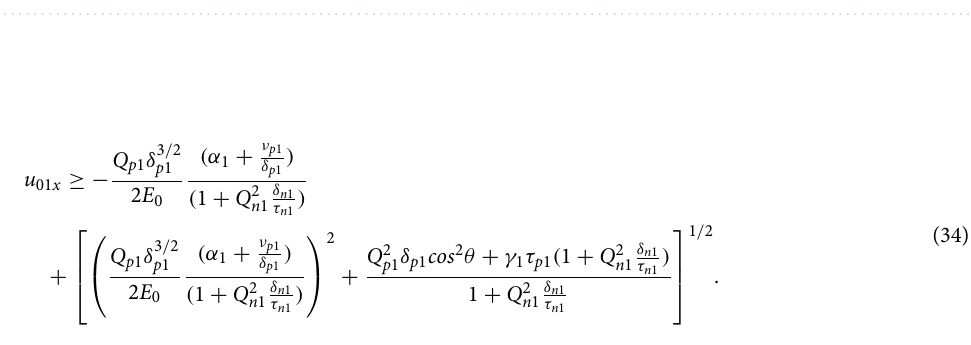
Figure 3. Variation of the normalized density distribution of the charged particles toward the wall for ν p 1 = 0, u 01 x = 0.622, τ p 1 = 0 (dotted-dashed line), ν p 1 = 0, u 01 x = 0.804, τ p 1 = 0.2 (dotted line), ν p 1 = 0.005, u 01 x = 0.622, τ p 1 = 0 (dashed line) and ν p 1 = 0.005, u 01 x = 0.804, τ p 1 = 0.2 (solid